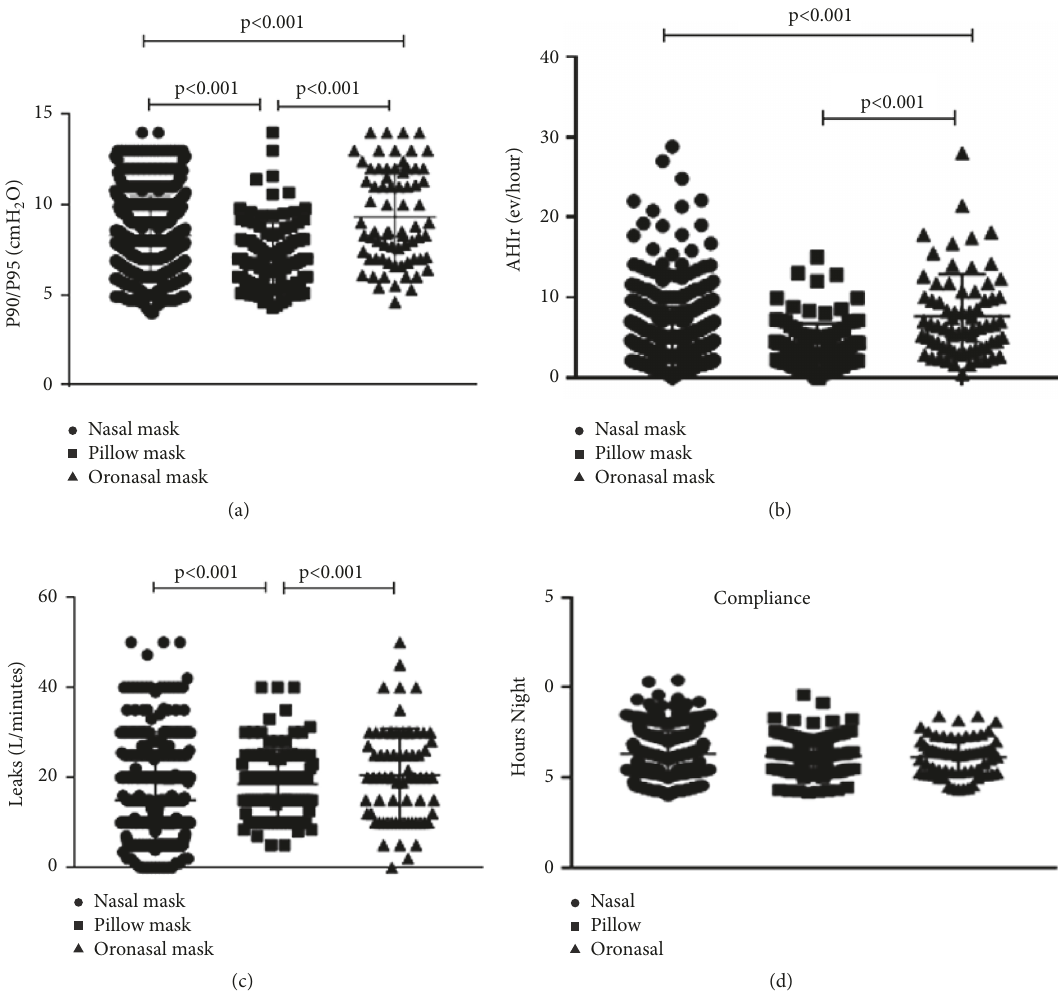
Figure 4: Comparison of effective pressure in the 90/95 percentile for APAP (a), residual apnea-hypopnea index (b), mean leak in L/m (c), and APAP adherence for different types of interfaces